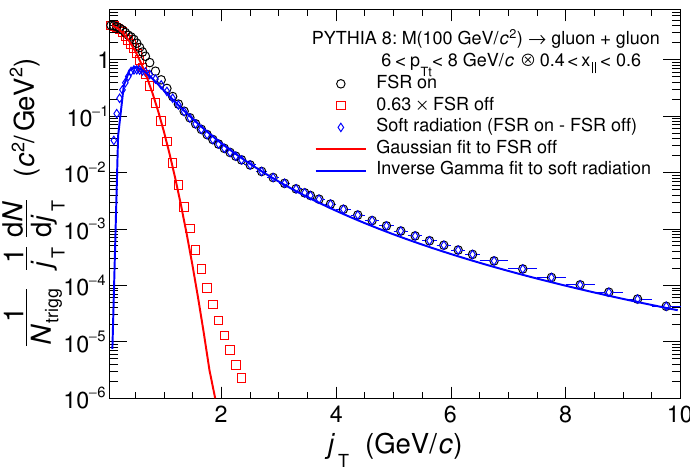
Figure 2 . Results from a Pythia 8 study with a di-gluon initial state. The circular symbols are obtained when the (cid:12)nal-state shower is enabled. The square symbols show the distribution without (cid:12)nal-state showering. The diamond symbols representing soft radiation are obtained as a di(cid:11)erence between the other two distributions. The distribution without (cid:12)nal-state showering is (cid:12)tted with a Gaussian and the soft radiation part with an inverse gamma